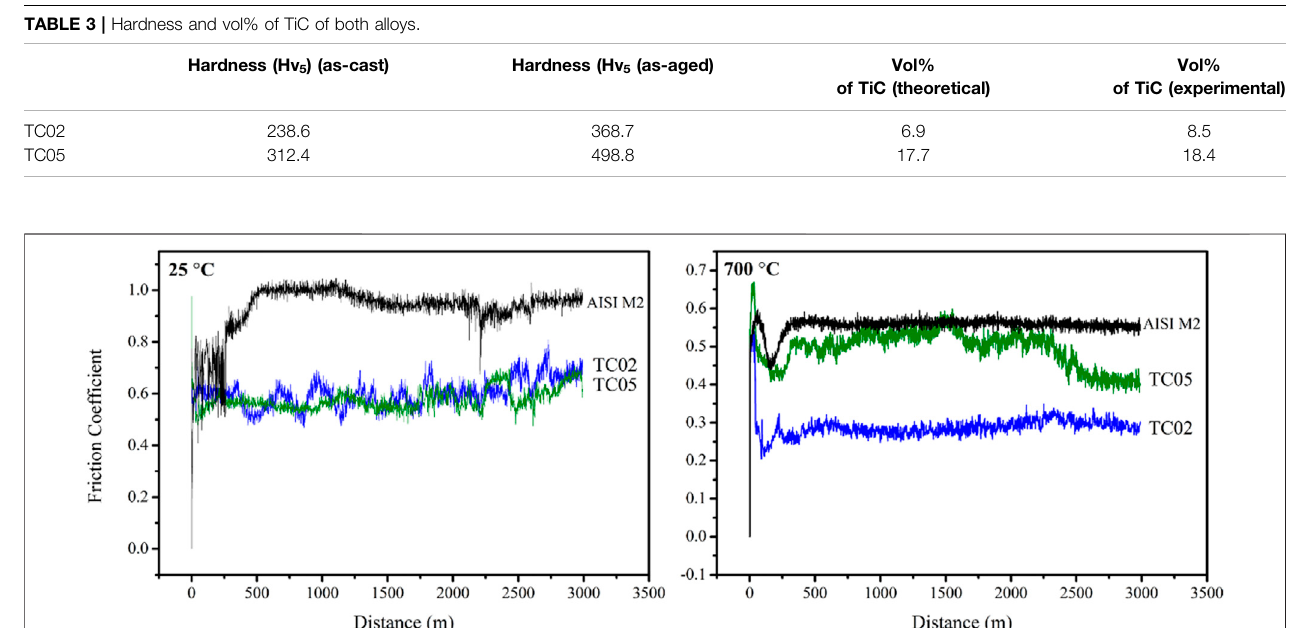
FIGURE 4 | Friction coef fi cient curves of as-prepared